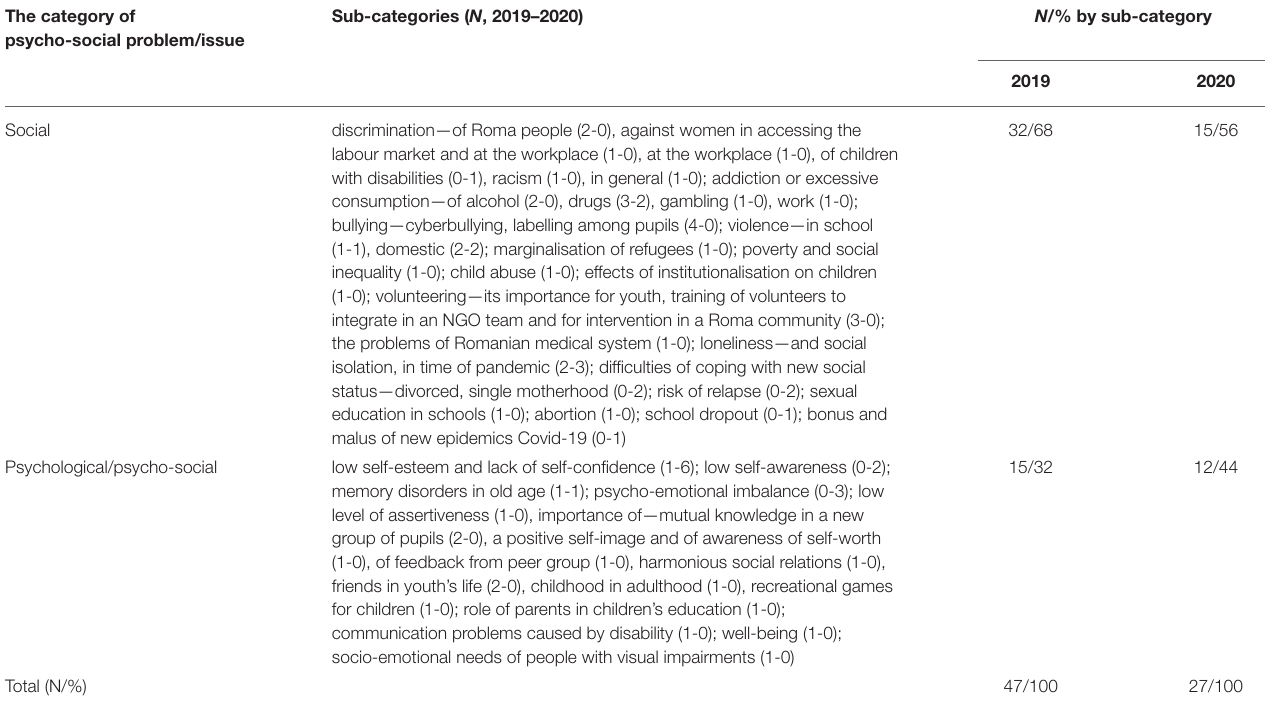
TABLE 5 | The psycho-social problem/issue elected by students who conducted Social Work Methods with Groups workshops in the online learning environment − 2020 and 2019 cohorts. The category of psycho-social